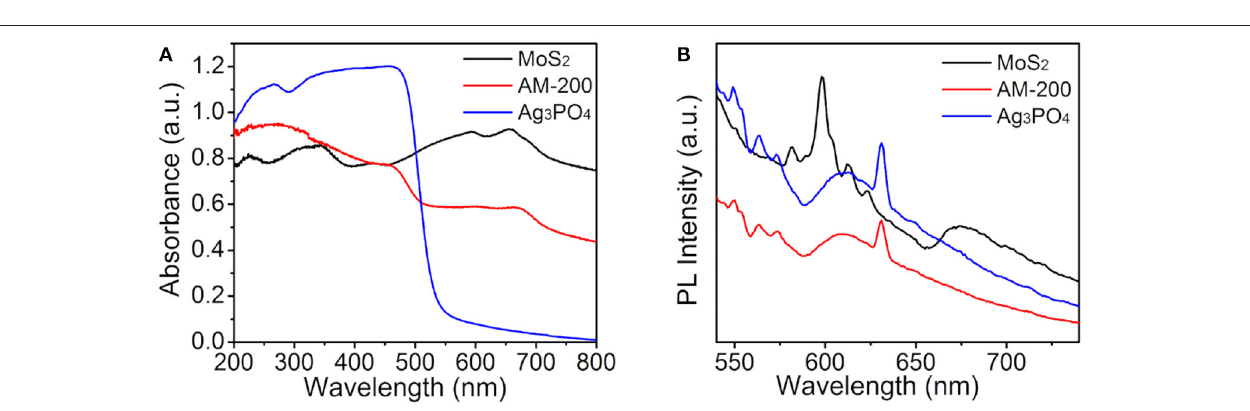
FIGURE 5 | UV-vis DRS (A) and PL spectra (B) of pure Ag 3 PO 4 , MoS 2 and the composite AM-200.